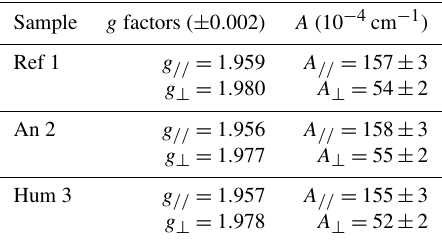
Table 2. EPR parameters of VO-P complexes in the Ref 1, An 2 and Hum 3